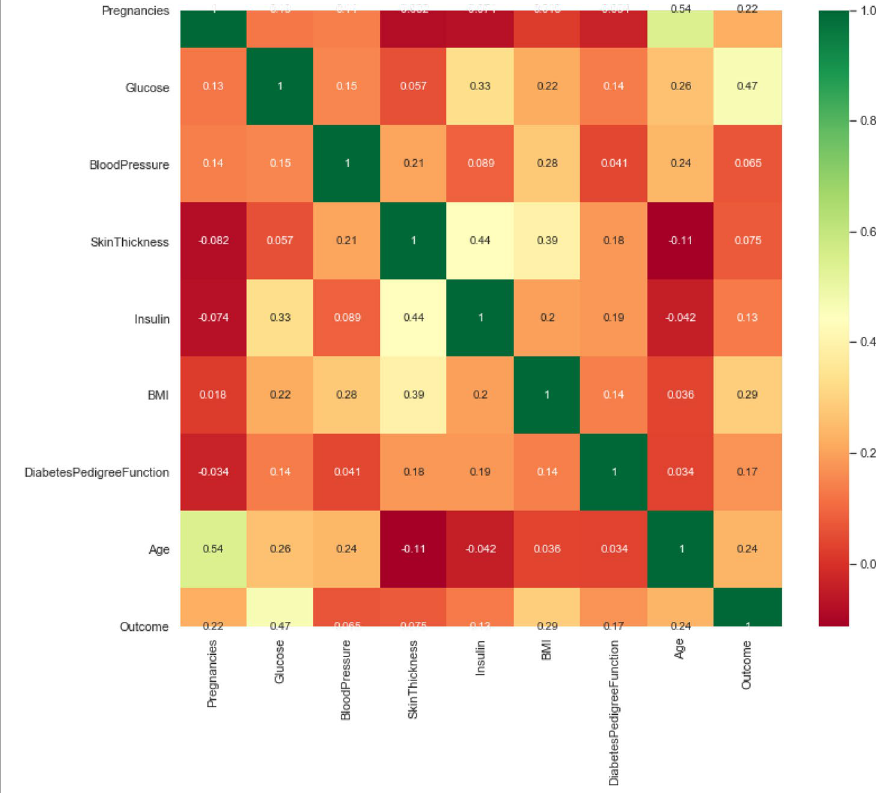
Fig. 11 Correlation analysis between all features presented in the